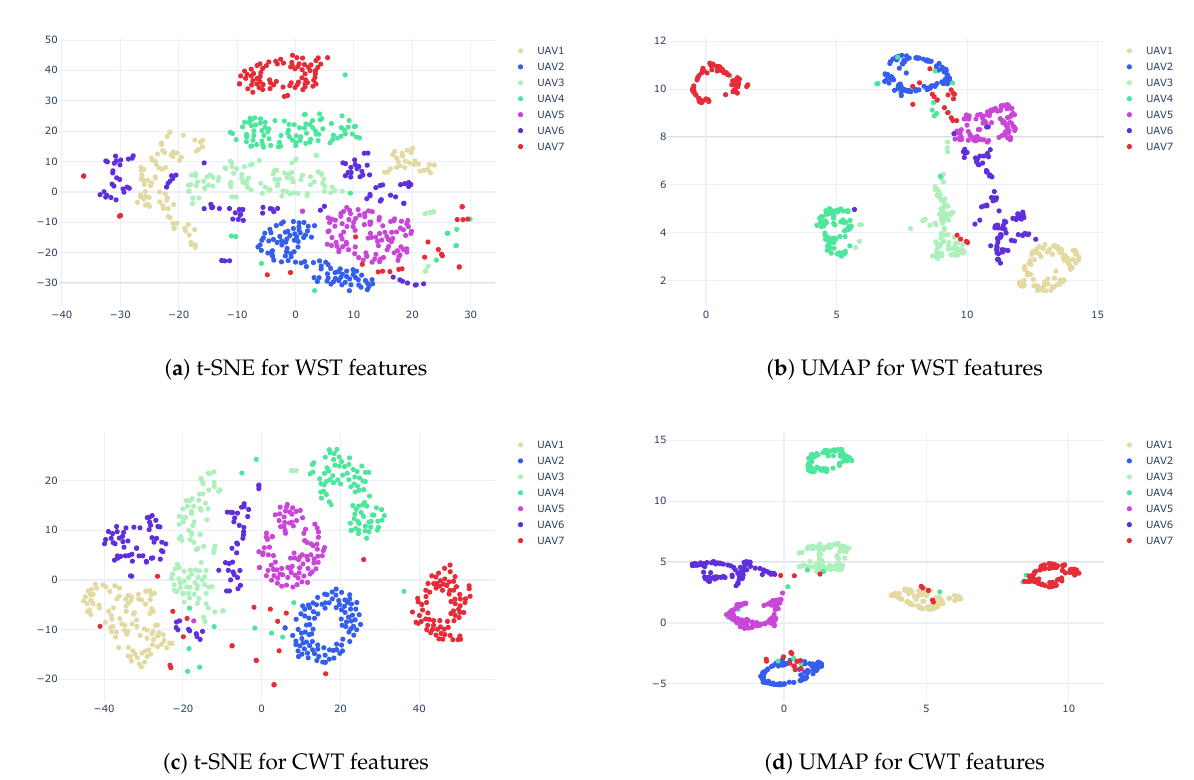
Figure 17. Clustering results using t-SNE and UMAP for both WST ( a , b ) and CWT ( c , d